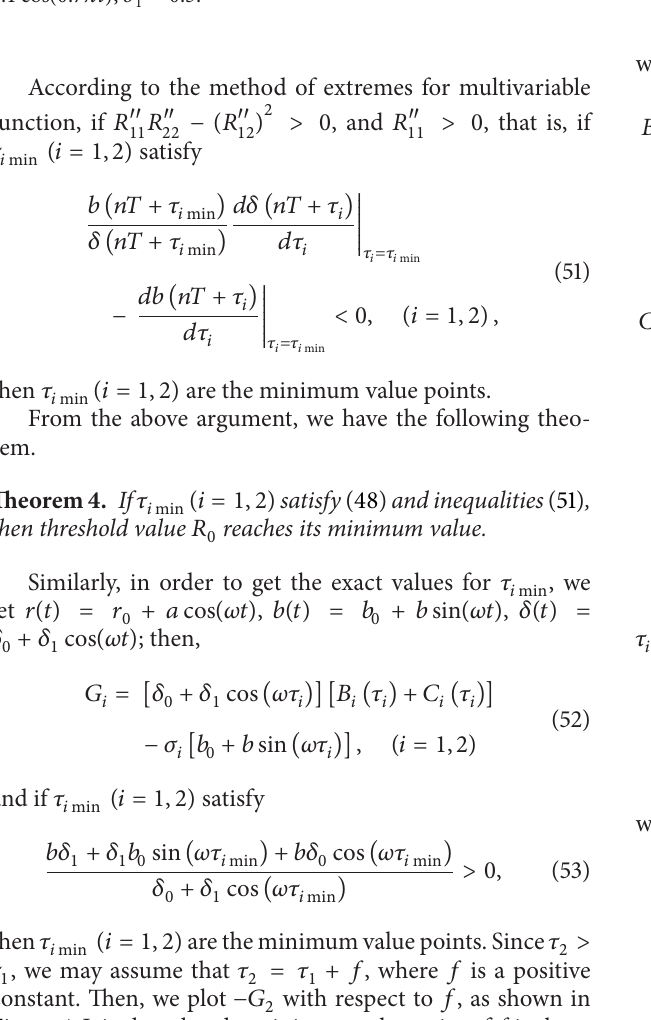
Figure 4: Illustrationsof existences of 𝜏 𝑖 min (𝑖 = 1, 2) . The parameter values are fixed as follows: 𝑏(𝑡) = 1 + 0.2 sin (0.7𝜋𝑡) , 𝛿(𝑡) = 0.5 + = 0.5 0.1 cos (0.7𝜋𝑡) , 𝜎 1